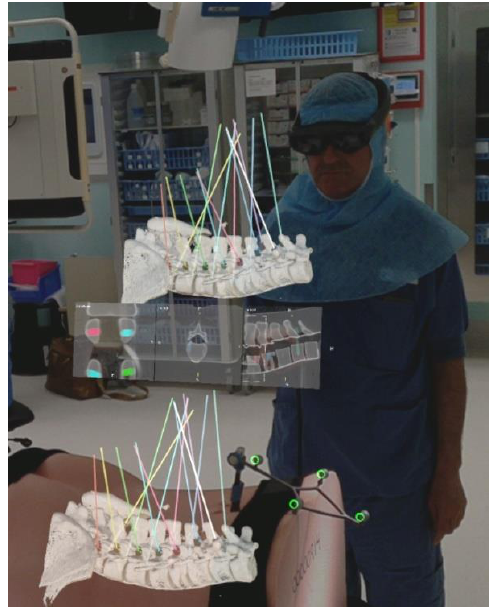
Figure 1. Surgeon’s view through the HMD presenting 2D and 3D information. The 3D overlay contains the planned 3D screws with protruding trajectory lines to assist instrument alignment. The lower 3D model is augmented onto the spine of the phantom while the 2D and 3D-representations seen floating above the phantom provide additional information and can be positioned freely in the virtual space and switched on and off. Additionally, note the colocalization of the green circles with the reflective spheres of the dynamic reference frame indicating accurate alignment.